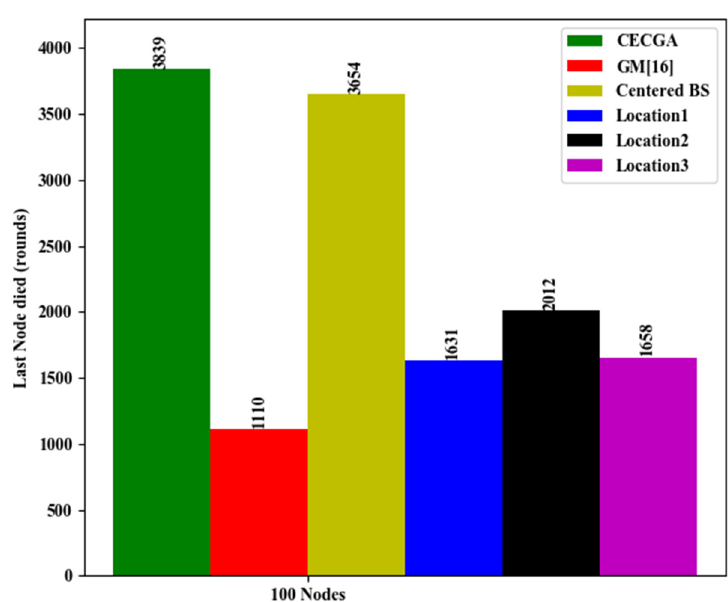
Figure 12. Last node death.